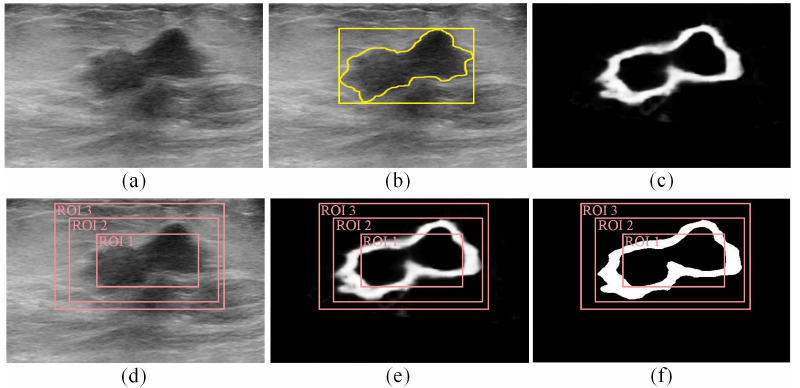
Figure 1. ( a , b ) ( a ) A malignant BUS image and ( b ) the corresponding gold standard tumor outline (yellow outline) and gold standard ROI (yellow box) that contains the tumor. ( c ) The edge map computed using the DexiNed model. ( d – f ) Three hypothetical ROIs (ROI 1, ROI 2, and ROI 3) overlaid on ( d ) the BUS image, ( e ) the edge map, and ( f ) the binarized edge